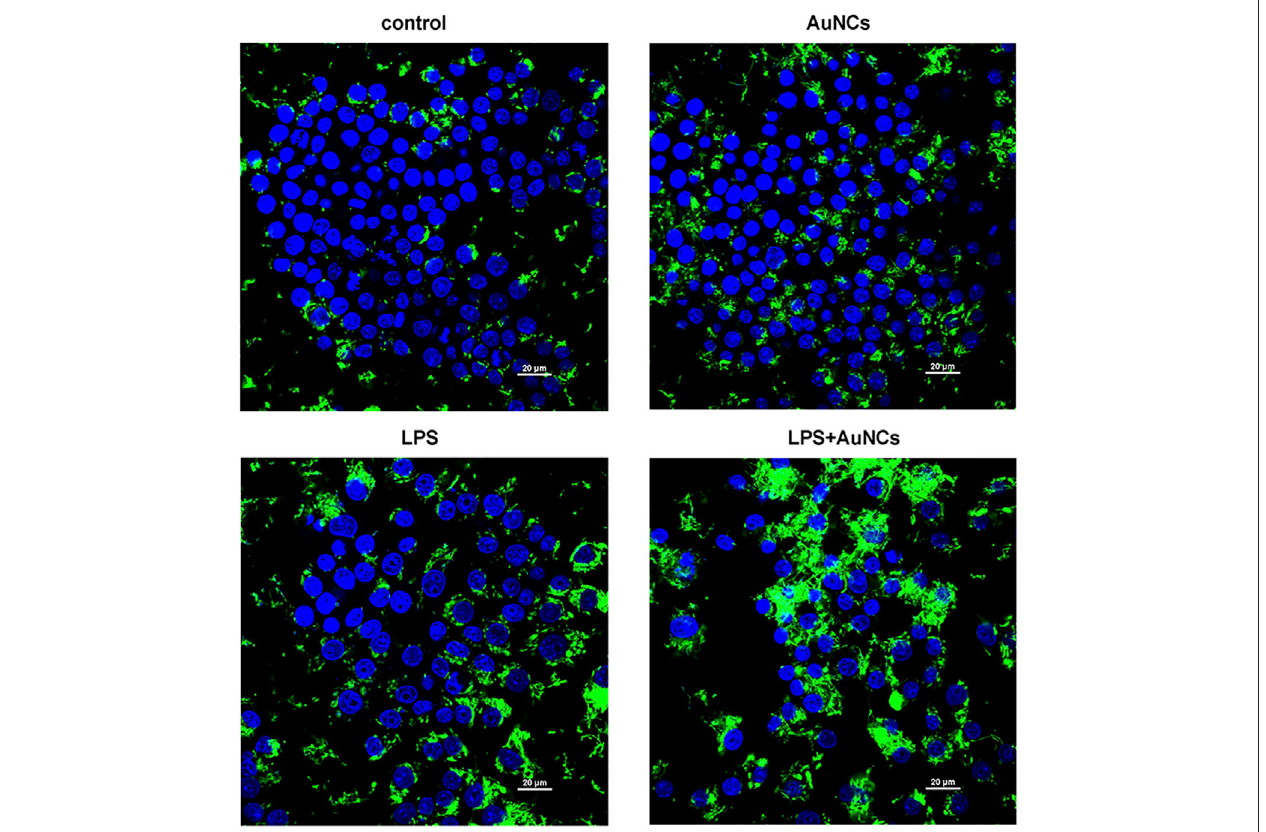
FIGURE 6 | Phagocytic activity changes of macrophages (blue) to F. nucleatum (green) following AuNCs (0.2 mM) treatment under normal and in fl ammatory conditions.